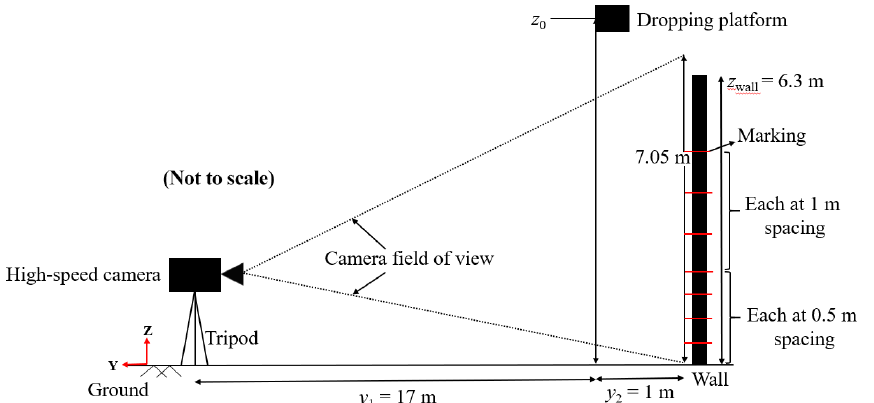
Figure 5. Schematic of the side view of the carcass drop experimental setup.